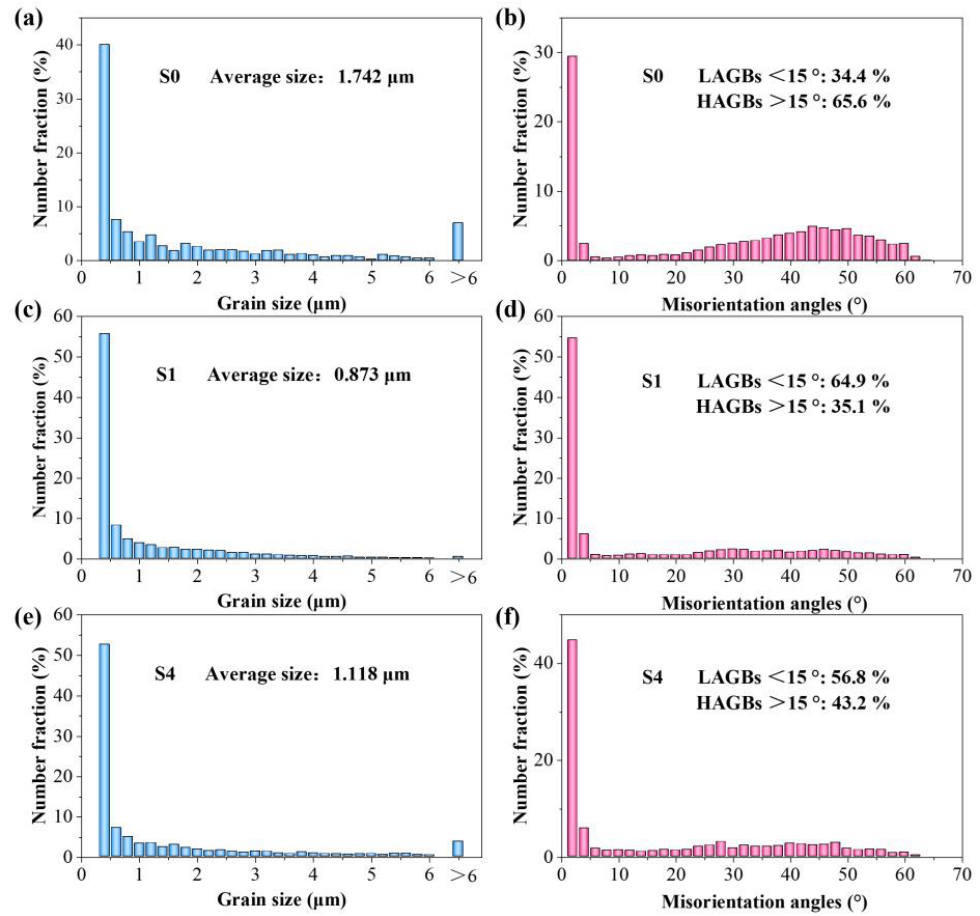
Figure 10. Grain size distribution statistics ( a , c , e ) and grain boundary misorientation angles distribution statistics ( b , d , f ); ( a , b ) S0; ( c , d ) S1; ( e , f ) S4.